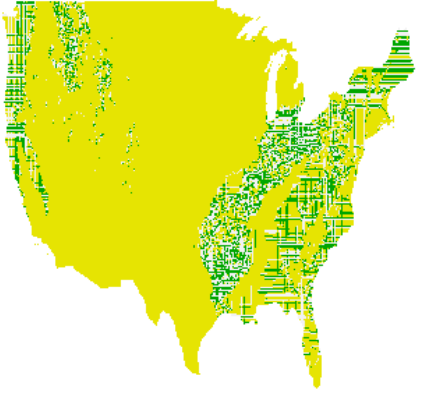
Figure 5. Comparison between positive divergence and negative divergence